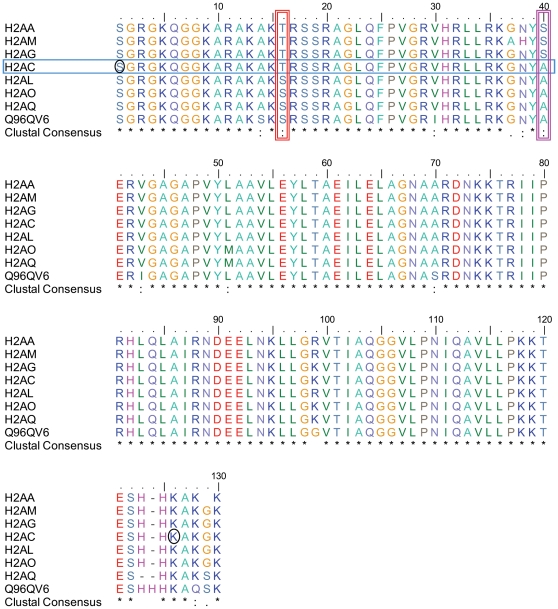
Sequence comparison of human H2A isoforms.The vertical boxes highlight the 16th and 40th amino acid residue position in the eight H2A variant sequences. The horizontal box shows the unique feature of H2AC, which has a threonine at the 16th position, but an alanine at the 40th position. We speculate that interactions of Thr-16 and Ala-40 in the H2AC variant may play a role in AngII-responsive Ser-1 dephosphorylation and Lys-125 methylation, the residues are shown in black circles.